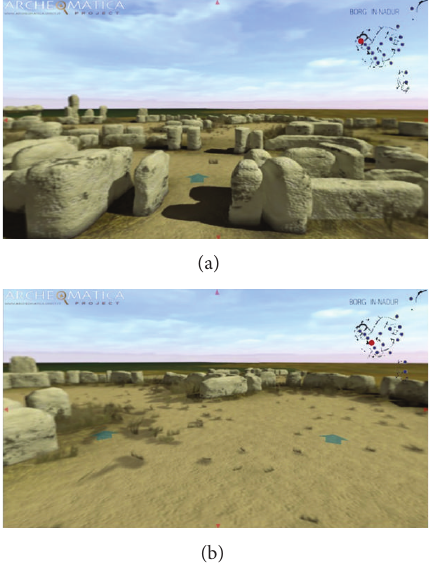
Figure 4: (a-b) Interface of the interactive virtual model (in the upper right corner the interactive map; blue arrows working as link for the navigation